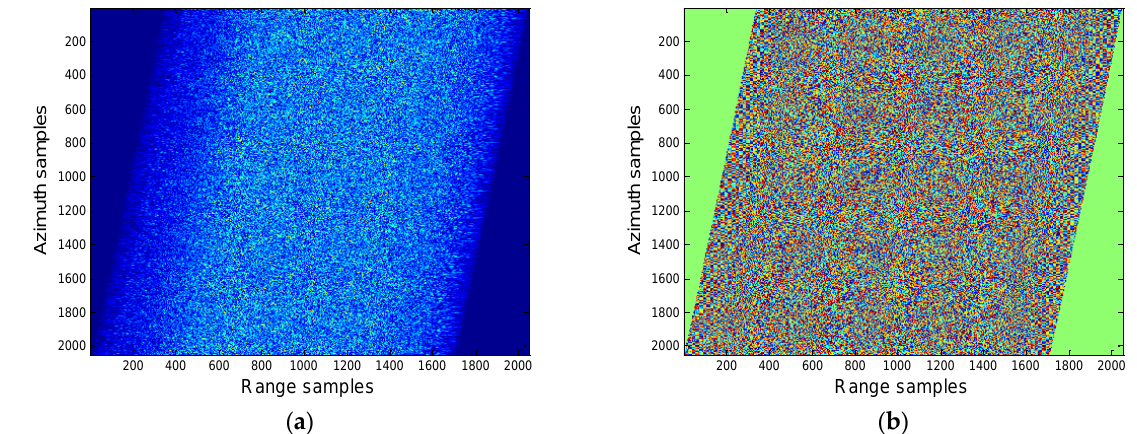
Figure 11. Generated raw signals of the simulated nature scene; ( a ) amplitude, ( b ) phase.